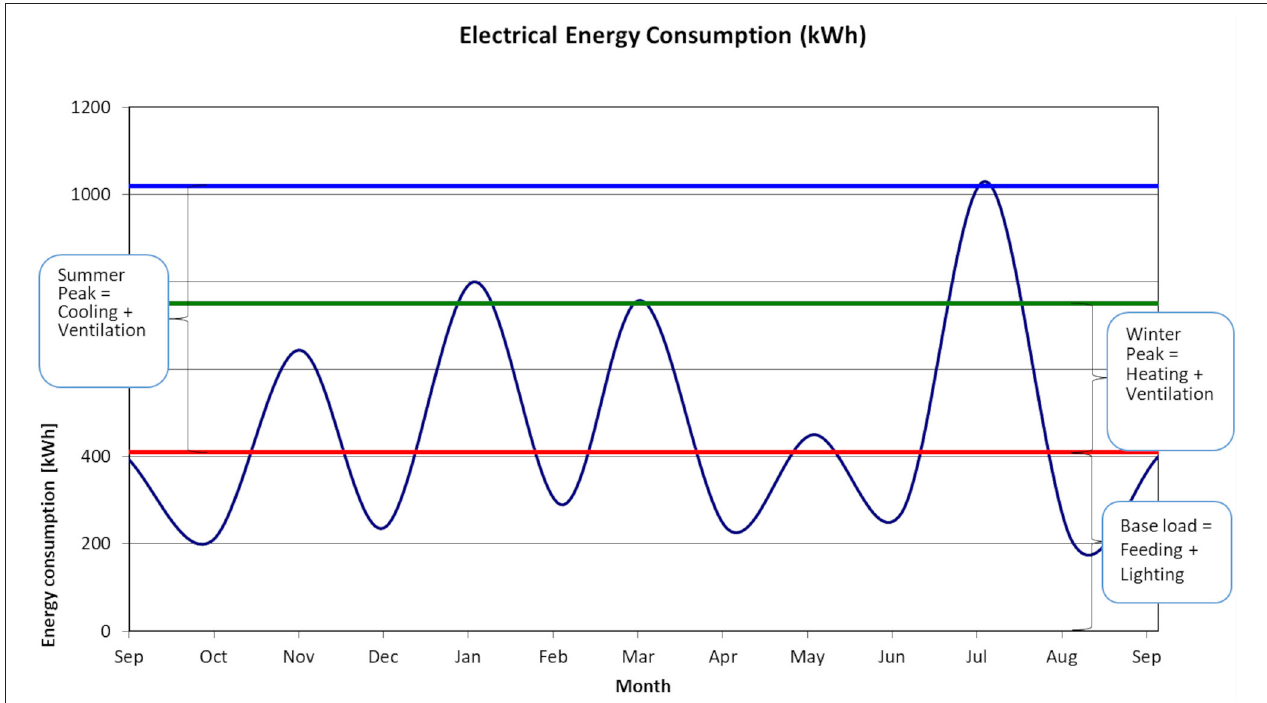
FIGURE 2 | Yearly pattern of electrical energy consumption in broiler